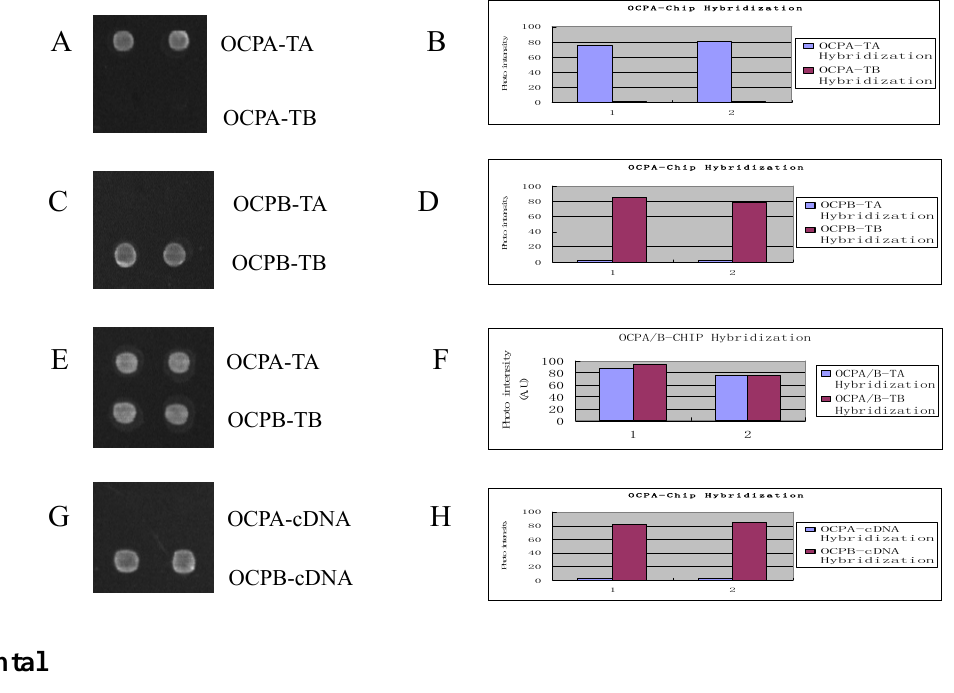
Figure 3. Images and signal intensity plot of the hybridization of RCA products to the DNA array. There are two sorts of probes: SSA (upper) and SSB (lower) on the chip. A and B showed the result of hybridization of OCPA-TA and OCPA-TB RCA products with chip probes; C and D showed the result of hybridization of OCPB-TA and OCPB-TB RCA products with chip probes; E and F showed the result of hybridization of mix of OCPA-TA and OCPB-TB RCA products with chip probes. G and H showed the result of the hybridization of OCPA-cDNA and OCPB-cDNA with chip